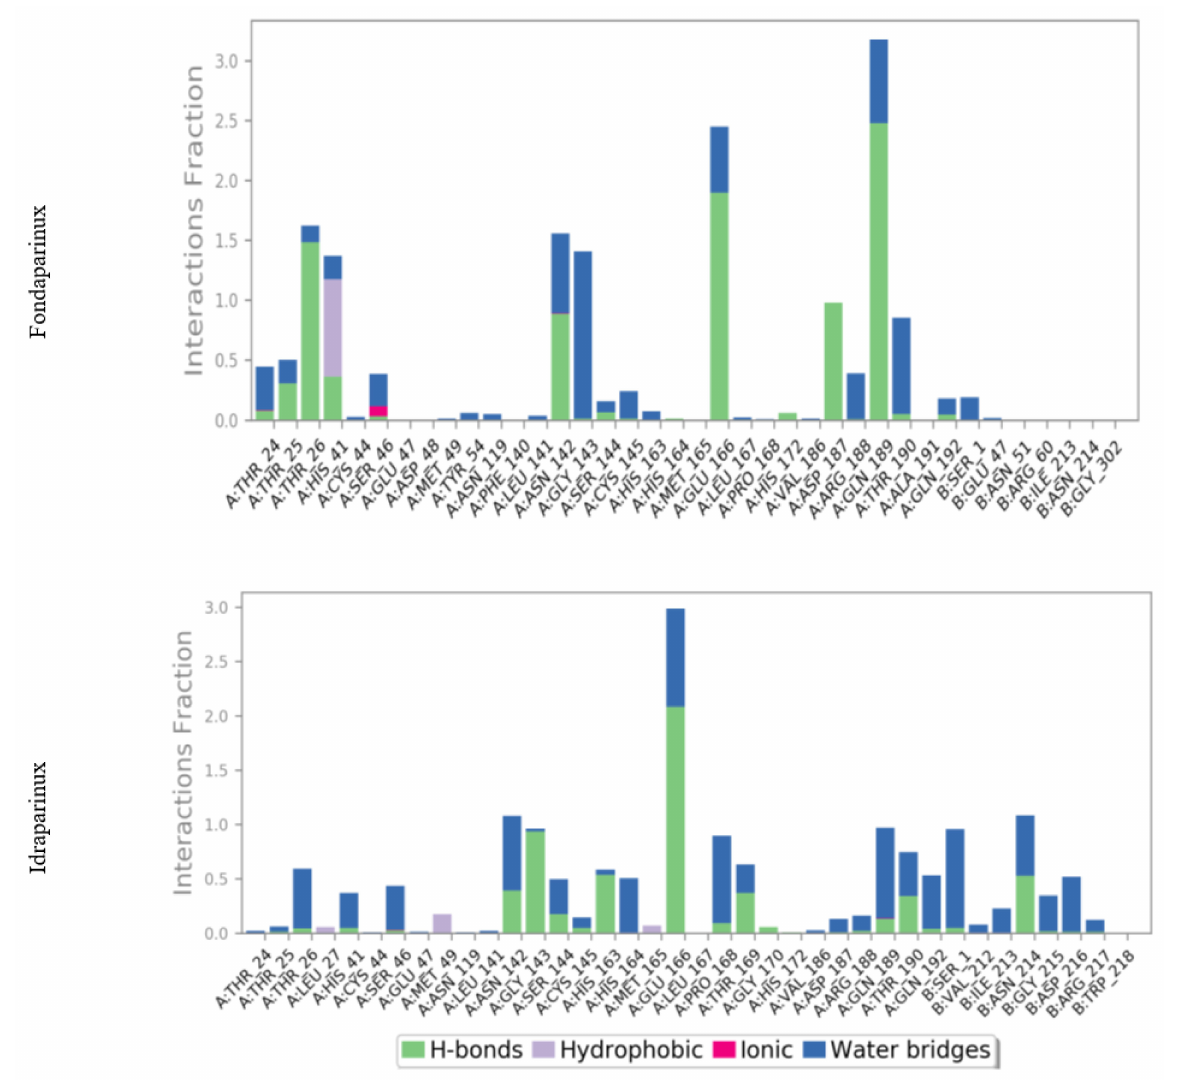
Figure 6. Histogram describing the binding interactions of fondaparinux and idraparinux within the SARS-CoV-2 M pro during the simulation time (200 ns).